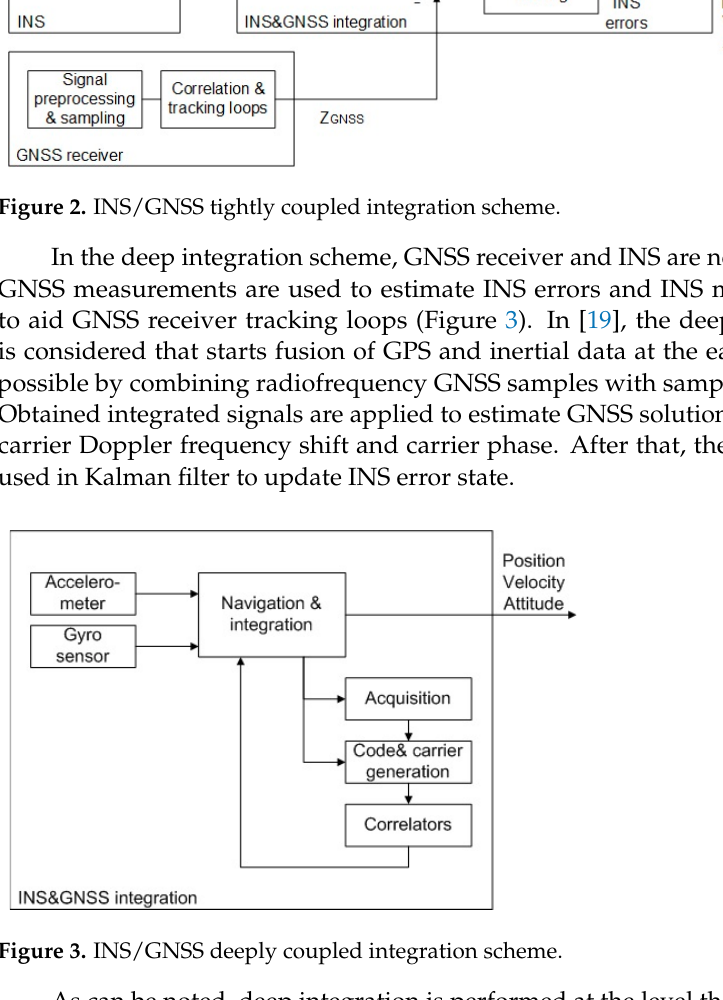
Figure 1. INS/GNSS loosely coupled integration scheme.